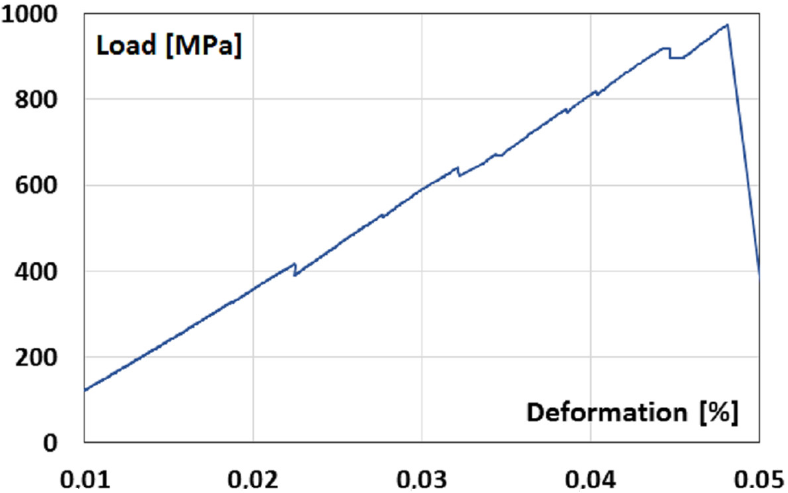
Figure 2. The load curve for the four-layer sample with the fiber orientation [0/90/90/0]. The fibers of the outer layers are oriented along a direction of external loading.